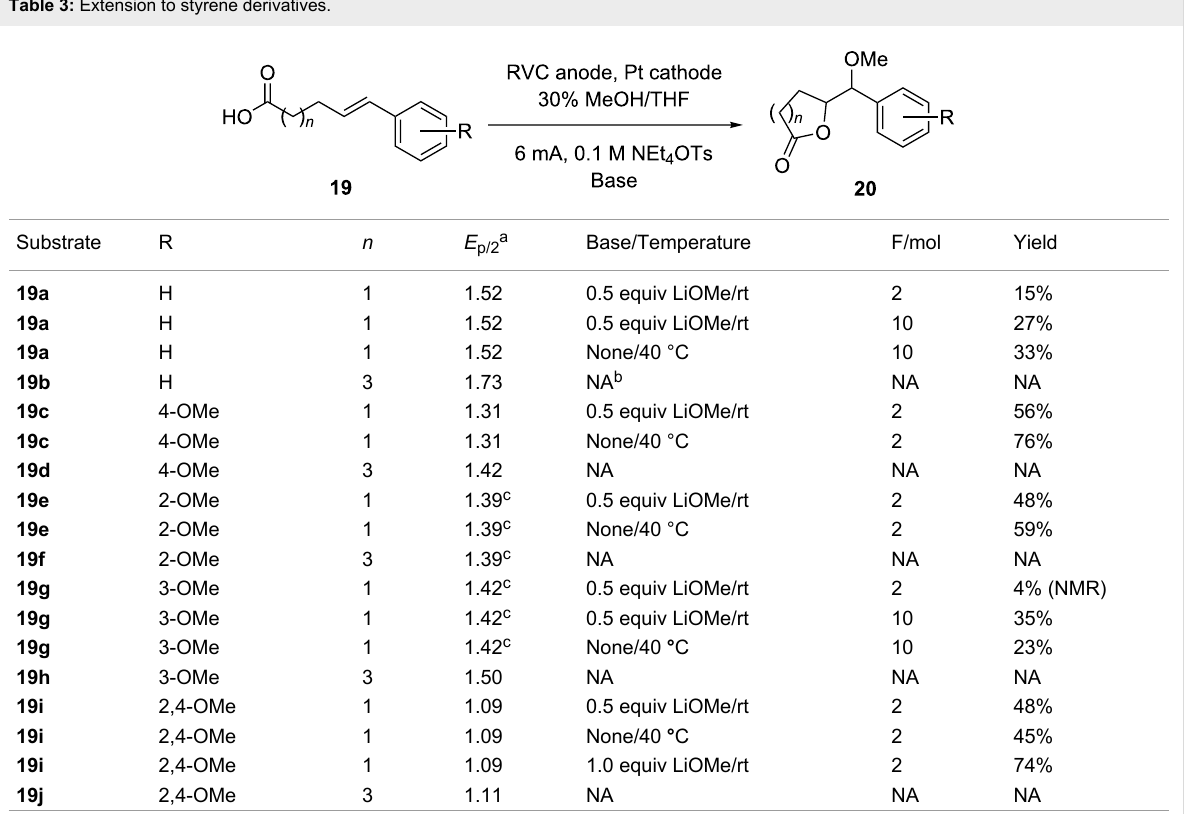
Table 3: Extension to styrene